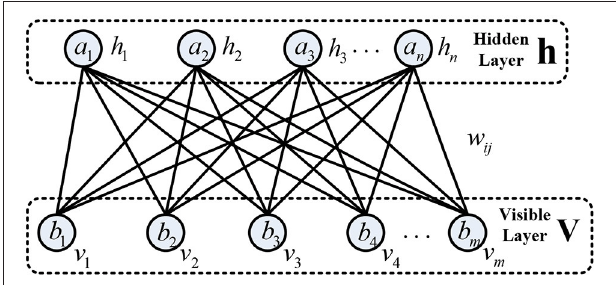
FIGURE 2 | The basic structure of restricted Boltzmann machine